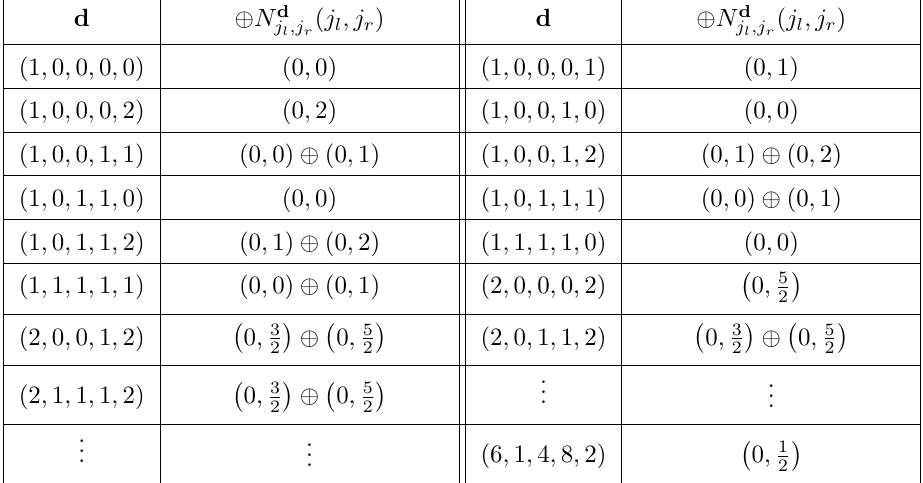
Table 32. BPS spectrum of the pure SU(5) 8 theory up to d 1 , d 5 ≤ 2 , d 2 , d 3 , d 4 ≤ 1 together with the negative volume state of d = (6 , 1 , 4 , 8 , 2) . Here, d = ( d 1 , d 2 , d 3 , d 4 , d 5 ) labels state with